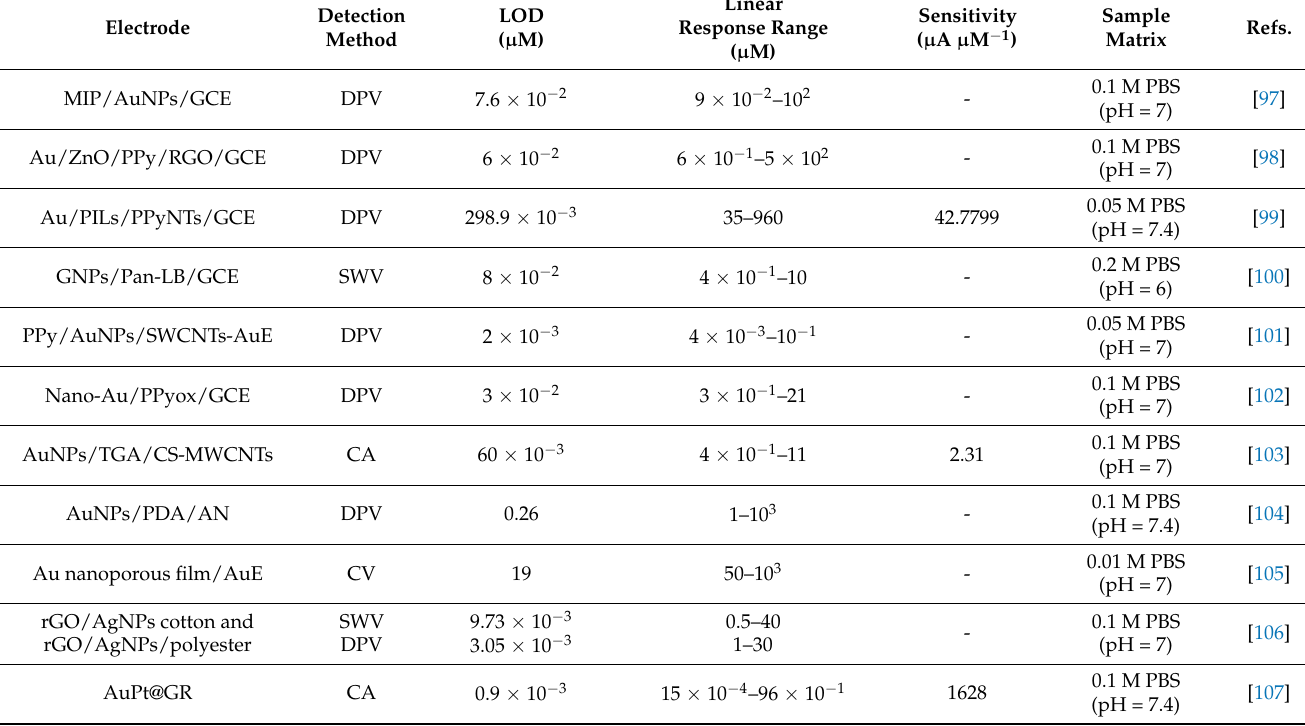
Table 3. Electrochemical sensors for EPI detection from recent